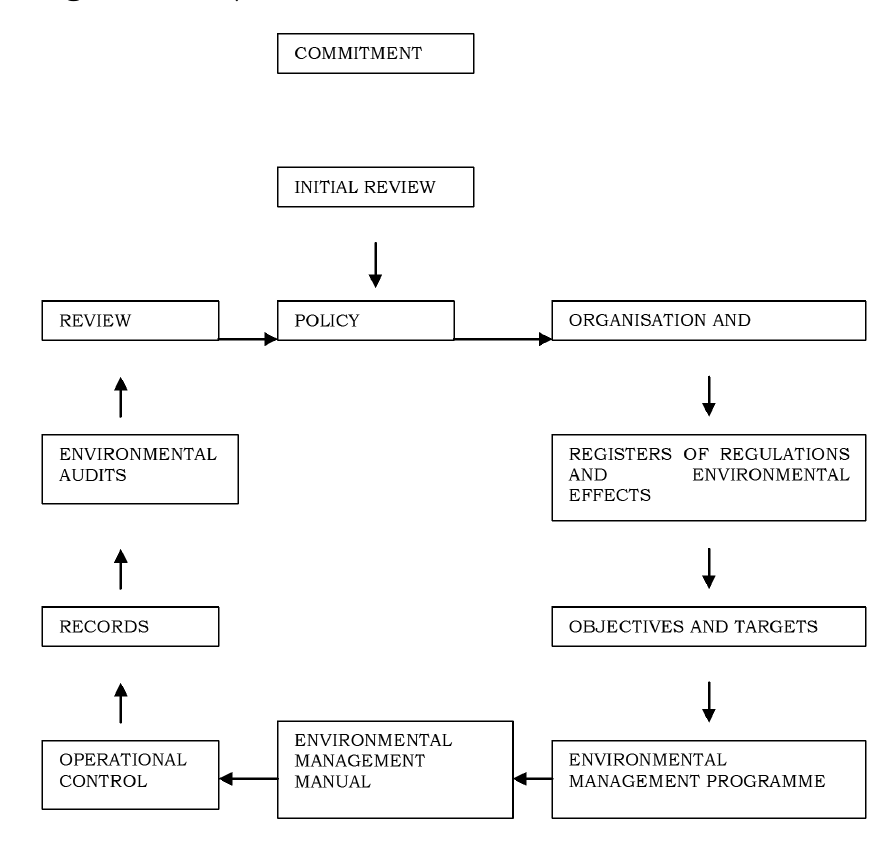
Figure 1: Environmental auditing within ISO 14001 (Source: Callaghan,